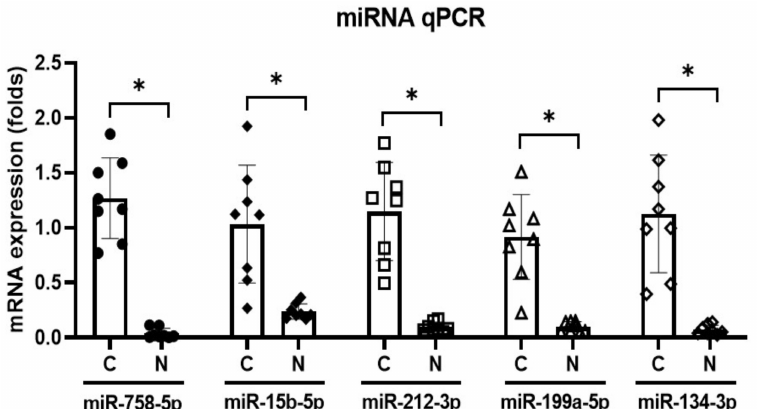
Figure 4. miR-758-5p, miR-15b-5p, miR-212-3p, miR-199a-5p, and miR-134-3p expression was re- duced in the noise-exposed rats ( n = 8 per group; * p < 0.05; unpaired t -test between control and noise-exposed